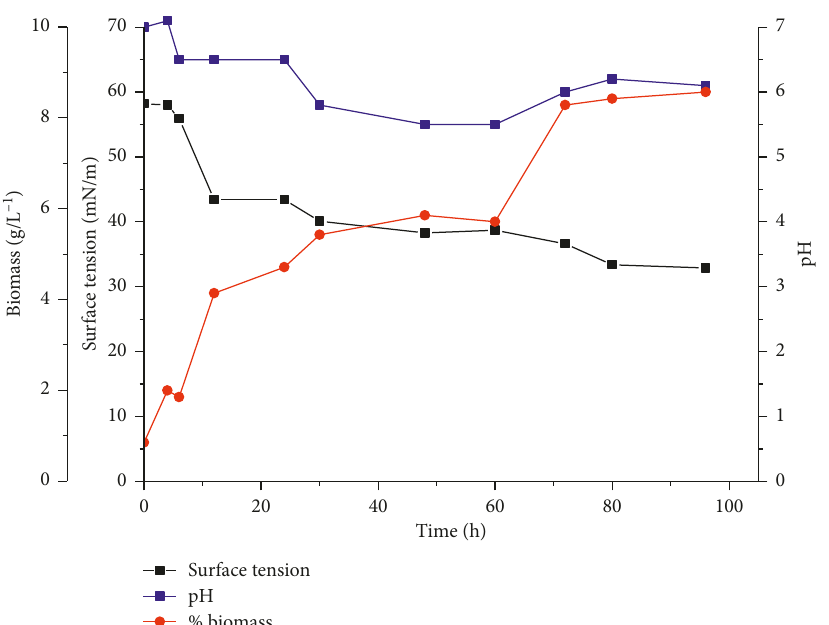
Figure 1: Growth profile, pH, and surface tension of Cunninghamella echinulata grown in the alternative medium constituted by instant noodle waste 2% (INW), corn steep liquor 2% (CSL), and soybean waste oil 0.5% (SWO).